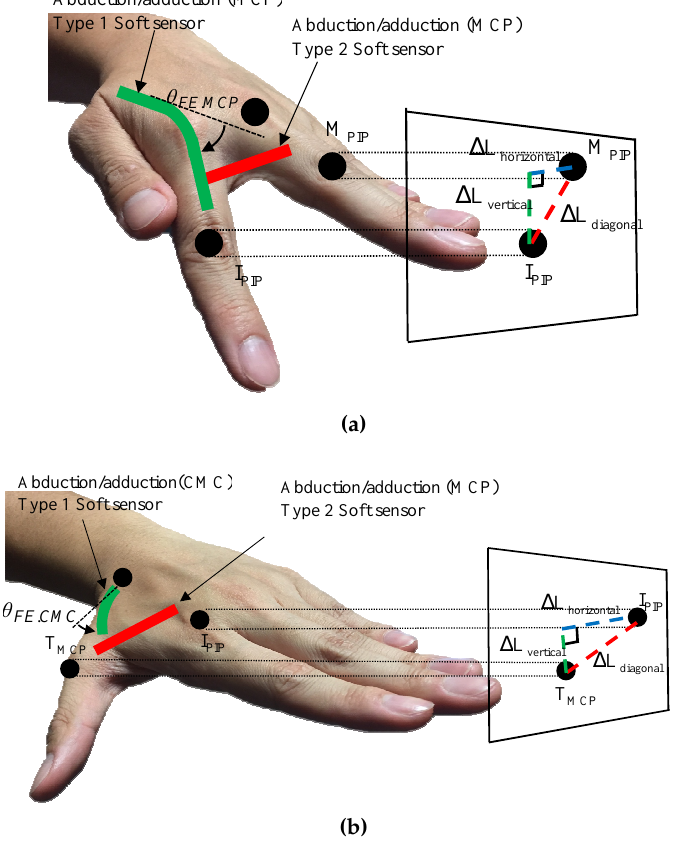
Figure 12. Decoupling algorithms for the sensor signals: ( a ) Decoupling algorithm for the MCP joint; ( b ) Decoupling algorithm for the CMC